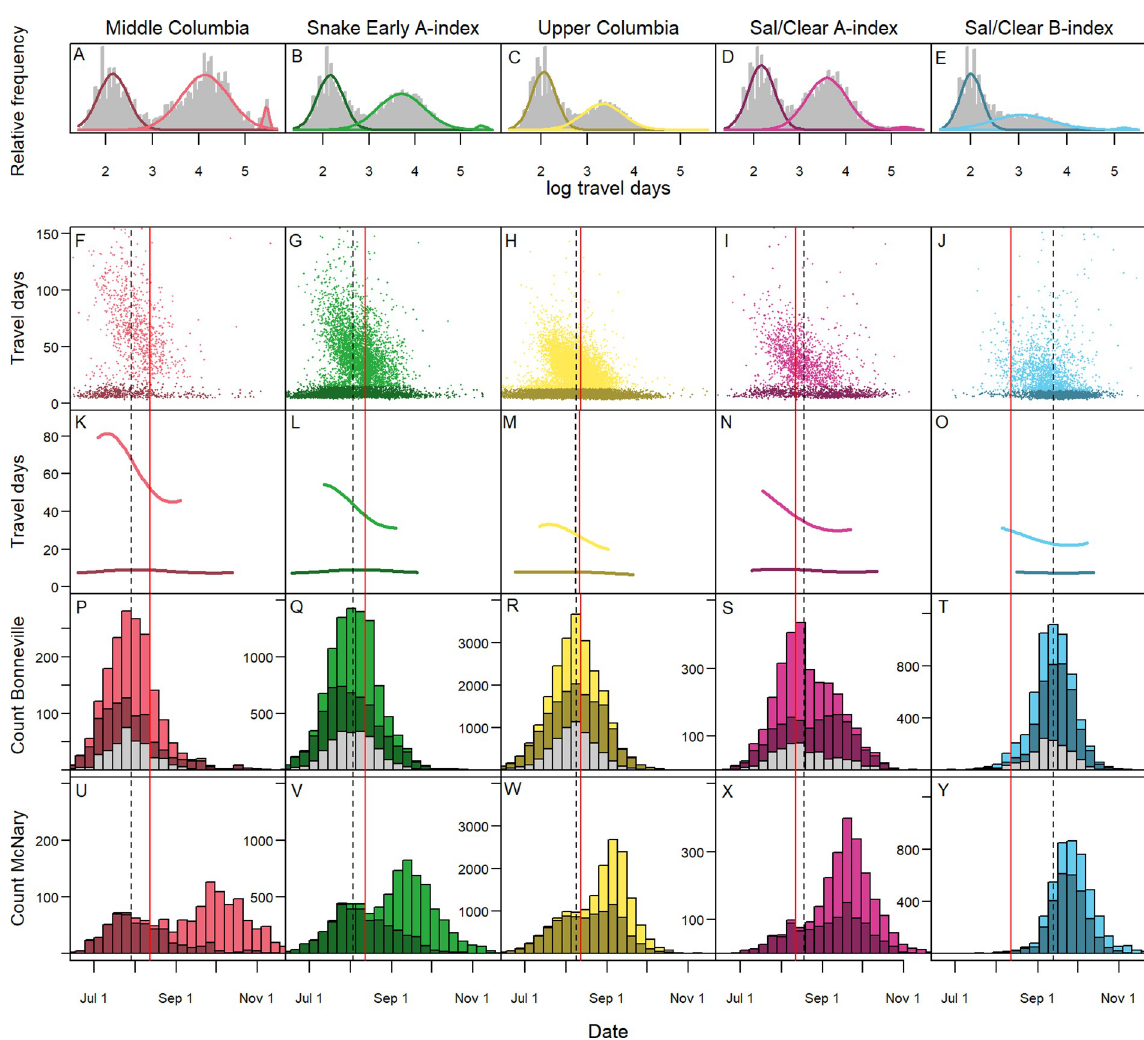
Fig 4. Migration patterns by population groups. Mixture model fits for each population group (A-E), scatterplots showing travel times by date for fish designated as fast (dark colors) and slow (light colors) respectively (F-J, overwintering fish shown in S1 Fig), GAMM smoothers for fast and slow fish respectively from Eq 2 shown for date ranges representing 95% of fish demonstrating respective behaviors (K-O), histograms of arrival dates at Bonneville Dam showing fast fish, delayed fish, and mortalities (in grey, P-T), and histograms of arrival dates at McNary Dam by migration behavior (U-Y). Vertical red lines represent date of peak temperatures averaged across study years and the vertical dashed lines represents median arrival date at Bonneville Dam for each population group